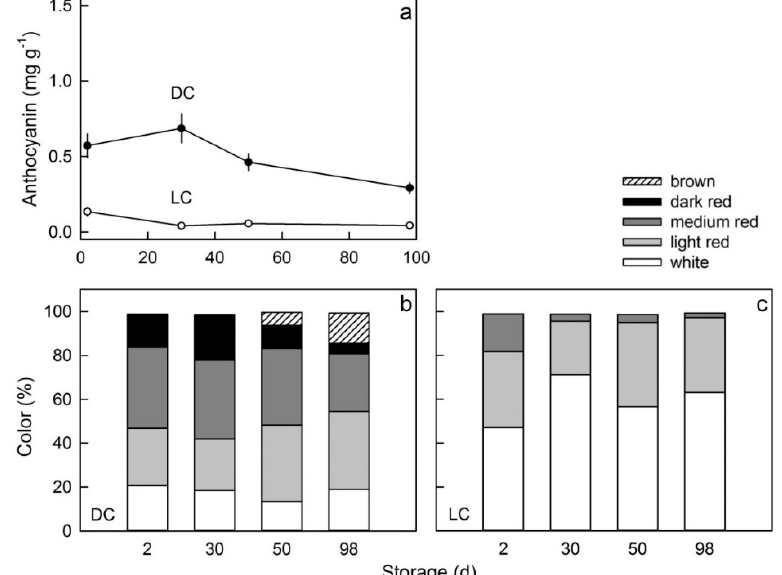
Figure 9. Time course of change in the anthocyanin content ( a ) and the color distribution ( b , c ) of red flesh apples of a dark-colored (DC) ( a , b ) and a light-colored (LC) clone ( a , c ) during storage. Fruit were held for up to 96 days after harvest.